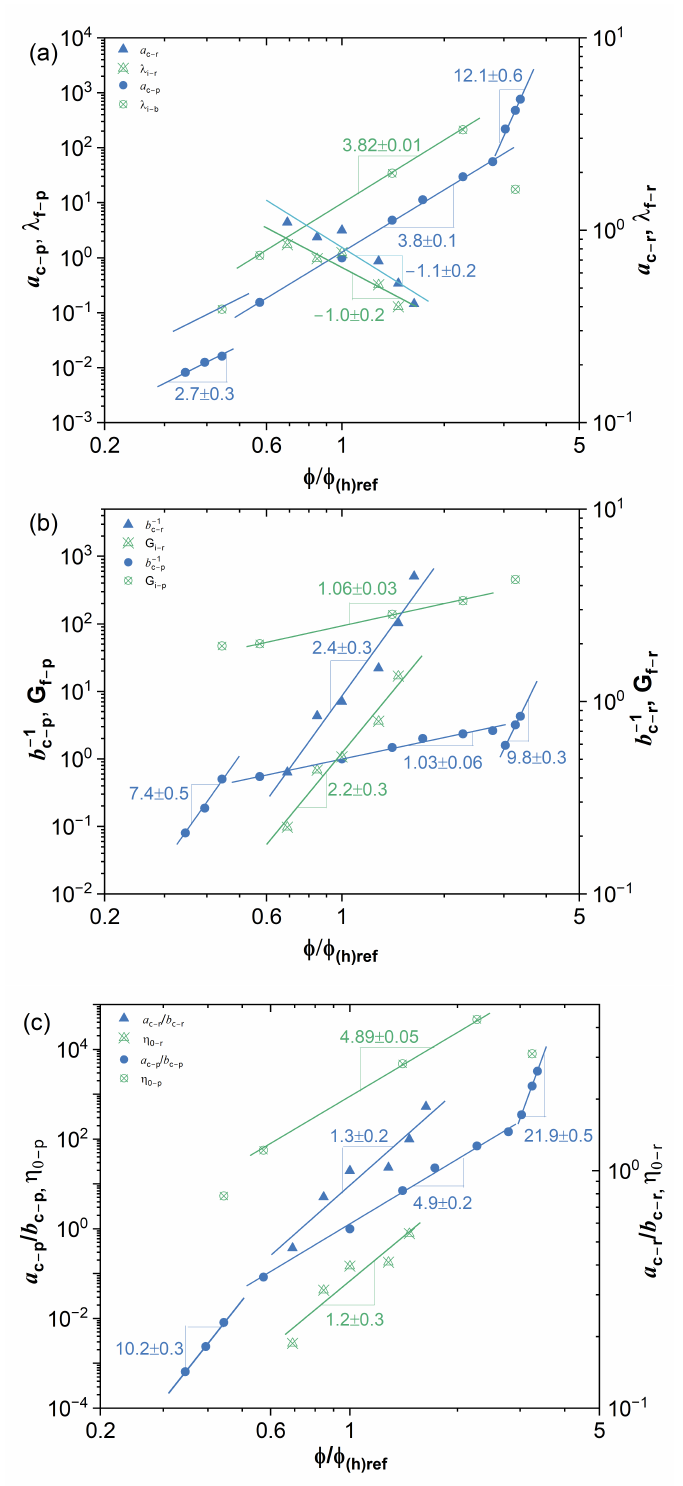
Figure 4. The concentration scaling of the estimated properties (hollow symbols, λ f , G f , η 0 ) and the shifting factors (solid symbols, a c , b − 1 c , a c / b c ), ( a ) is for the mean characteristic time, ( b ) is for the mean modulus, ( c ) is for the zero-shear viscosity. φ ref = 18% for Phormidium suspension (circle), φ href = 57.6% for human blood